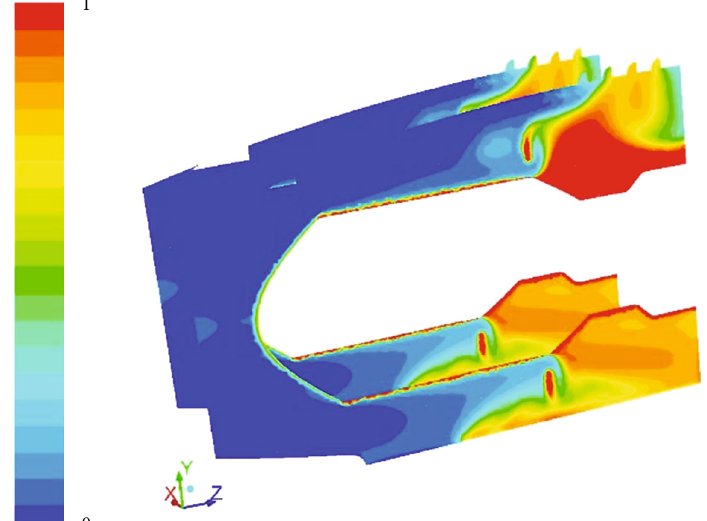
Figure 7: Temperature contours in two parallel vertical plains.